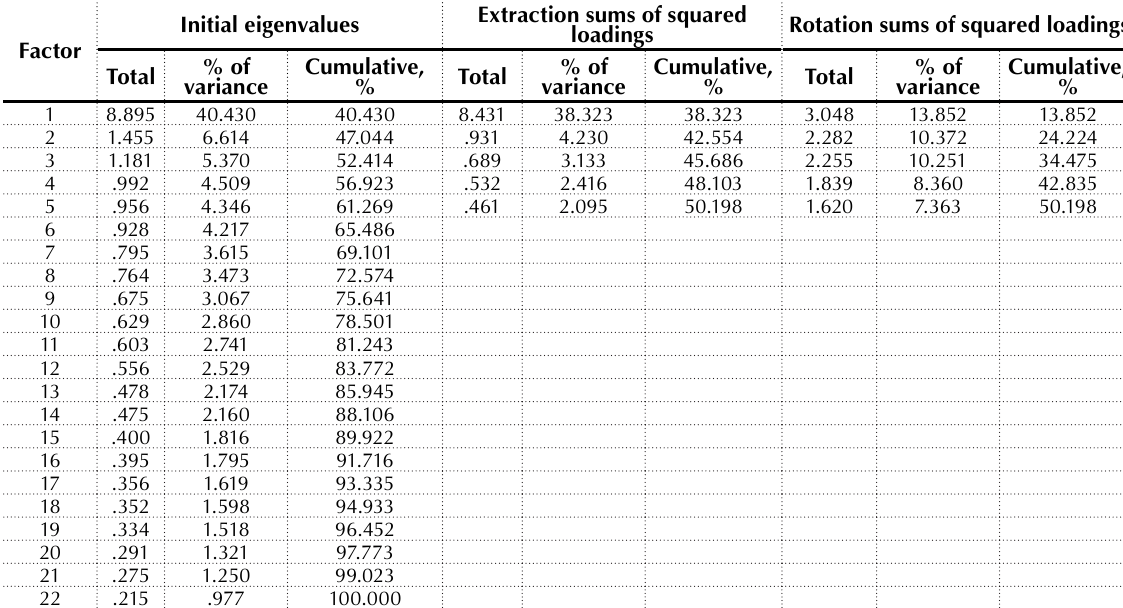
Table 3. Total variance explained for the service quality measurements Initial eigenvalues Factor